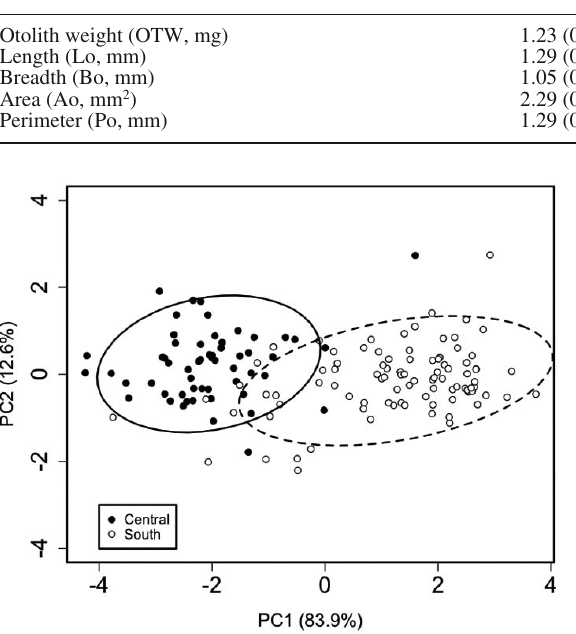
Fig . 5. – Scatterplot of factor scores from principal components analysis for otoliths of Strangomera bentincki . The ellipses repre- sent a 95% confidence interval.